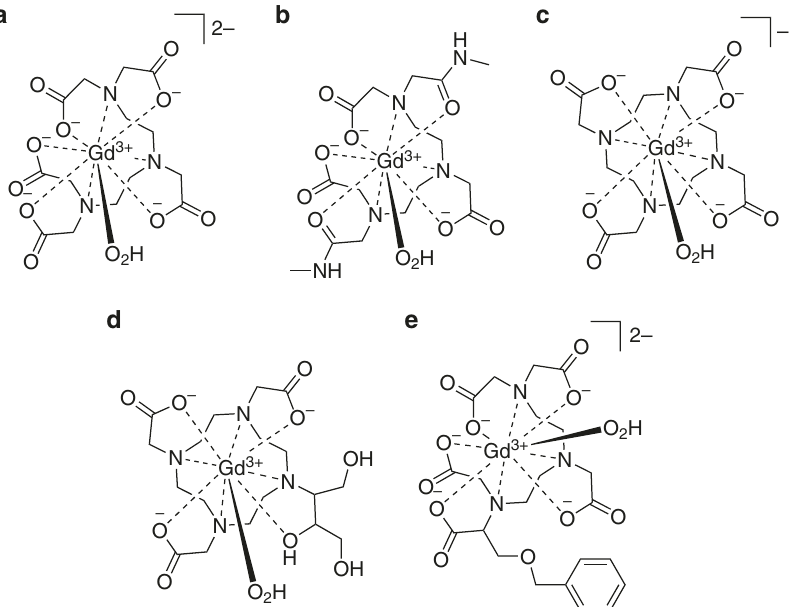
Fig. 1 The fi ve most commonly administered gadolinium-based contrast agents for clinical MRI 10 . a Magnevist ® , [Gd(OH 2 )(dtpa)] 2 − . b Omniscan ® , [Gd(OH 2 )(dtpa-bma)]. c Dotarem ® , [Gd(OH 2 )(dota)] − . d Gadovist ® , [Gd(OH 2 )(do3a-butrol)]. e Multihance ® , [Gd(OH 2 )(bopta)] 2